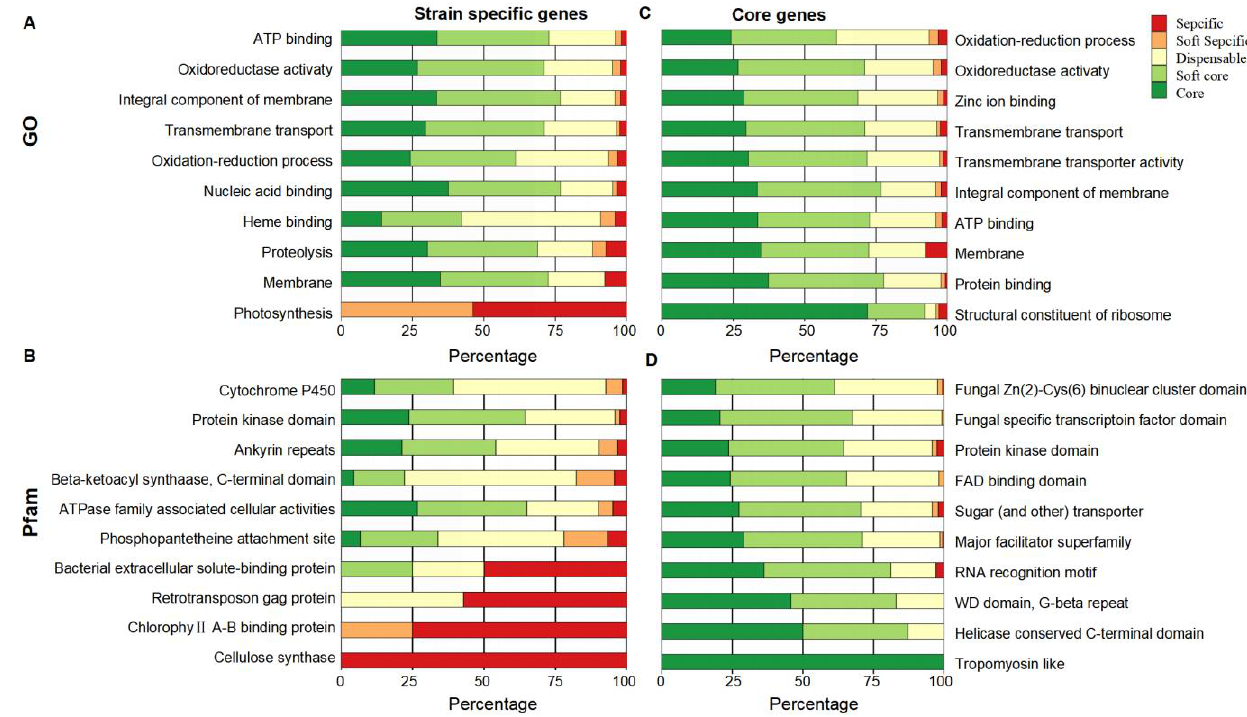
Figure 2. Functional enrichment analysis of different types of genes. ( A ) GO and enrichment analysis of strain-specific genes. ( B ) Pfam enrichment analysis of strain-specific genes. ( C ) GO enrichment analysis of core genes. ( D ) Pfam enrichment analysis of core genes.